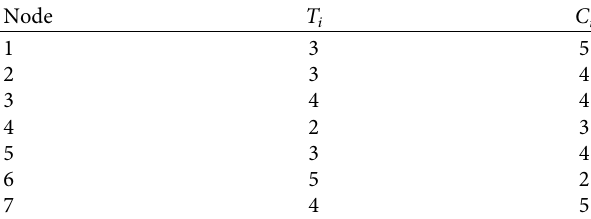
Table 2: Basic data of nodes for example I. Node